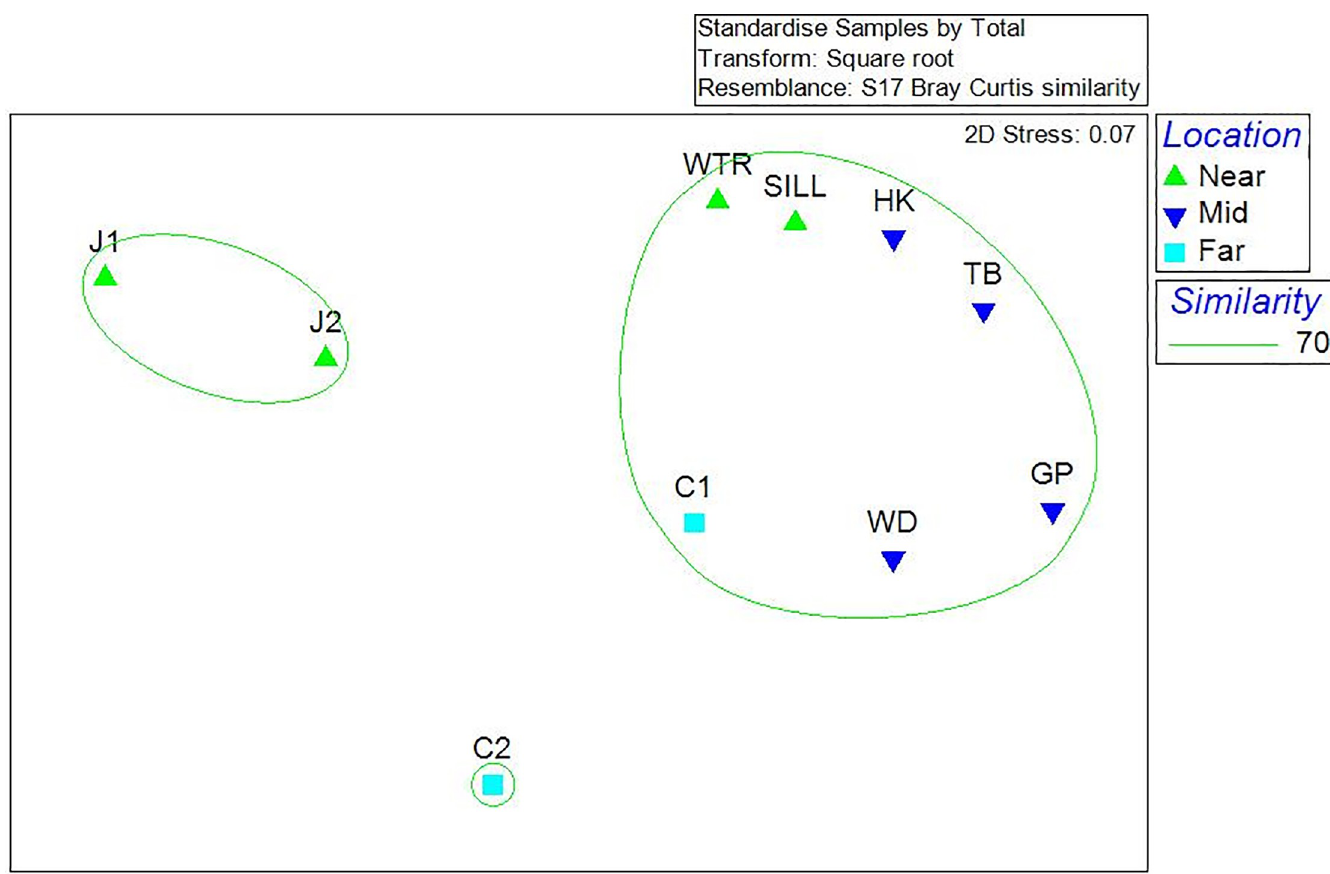
Fig 5. Non-metric multidimensional scaling plot. This graph represents the nMDS analysis in two-dimensional space. The nMDS used a Bray-Curtis similarity matrix calculated from percent coverage data that were standardized and square-root transformed. Green circles indicate 70%